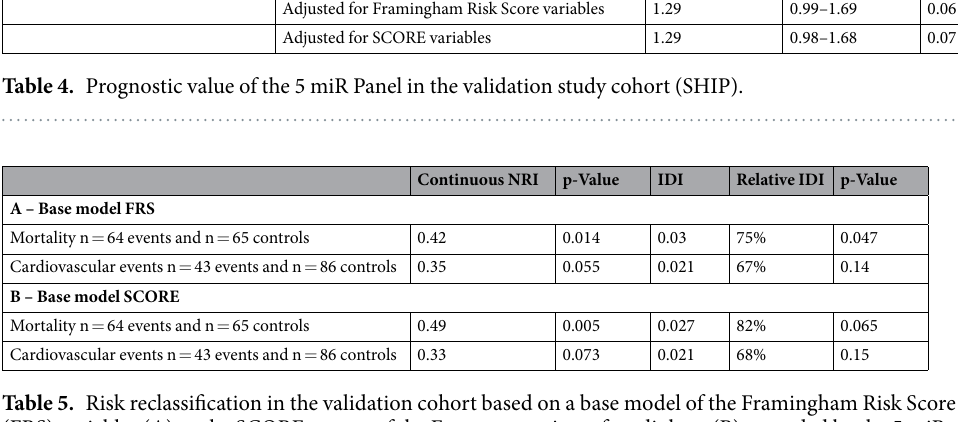
Table 5. Risk reclassification in the validation cohort based on a base model of the Framingham Risk Score (FRS) variables (A) or the SCORE system of the European society of cardiology (B) amended by the 5 miR Panel. NRI denotes net reclassification improvement and IDI denotes integrated discrimination